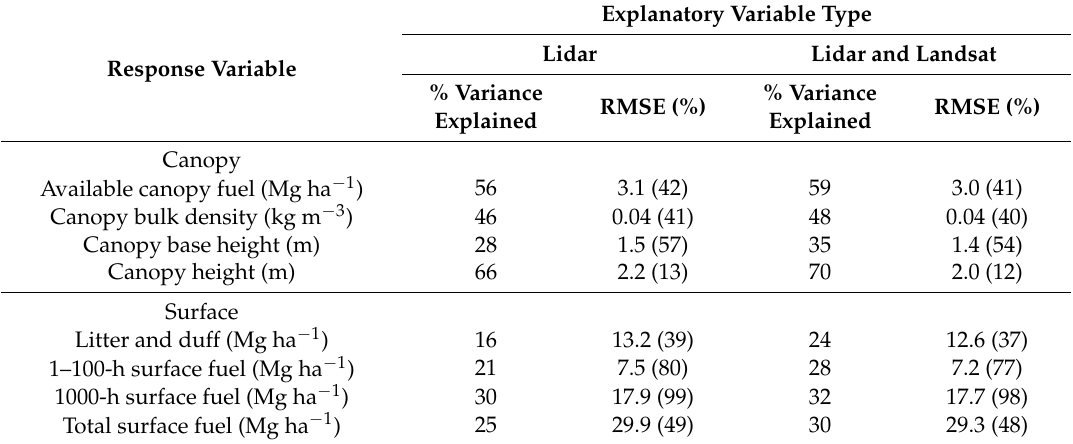
Table 4. Percent variance explained by and root mean square error (RMSE, %RMSE in parentheses) values of final random forest models predicting canopy and surface fuel response variables from lidar and Landsat explanatory